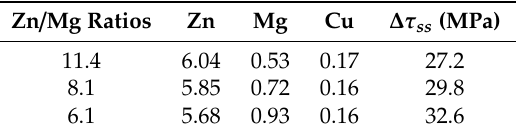
Solute concentration of samples in matrix (wt%) and calculating results of solid-solution